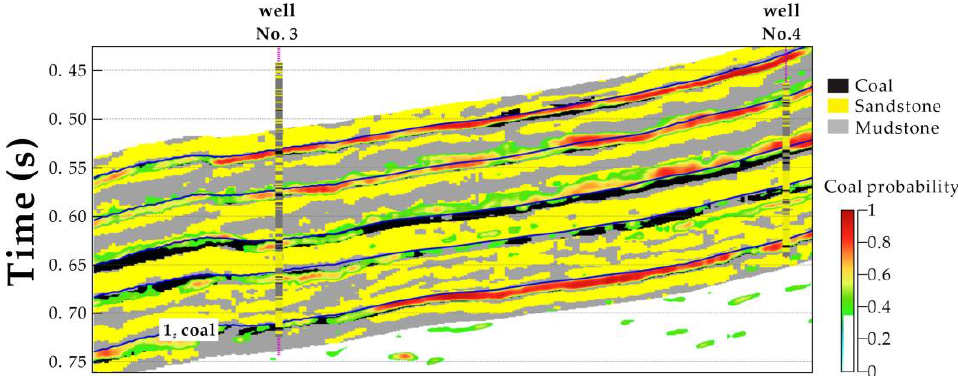
Figure 14. Inversion profile of lithology and reservoir holdup.